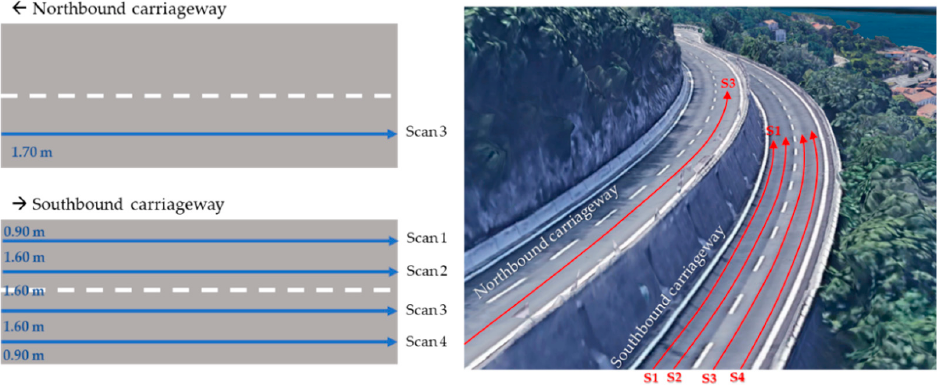
Figure 6. The scheme of acquisition adopted for GPR surveys.